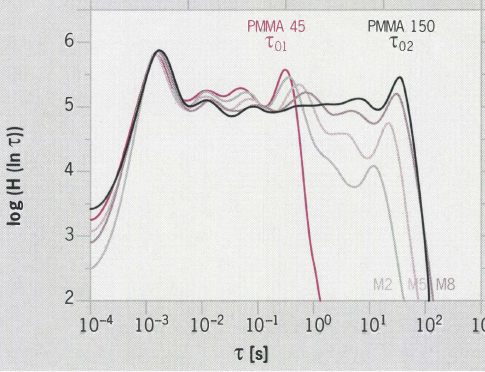
Relaxationszeitspektren fiir PMMA45 und PMMA150 sowie